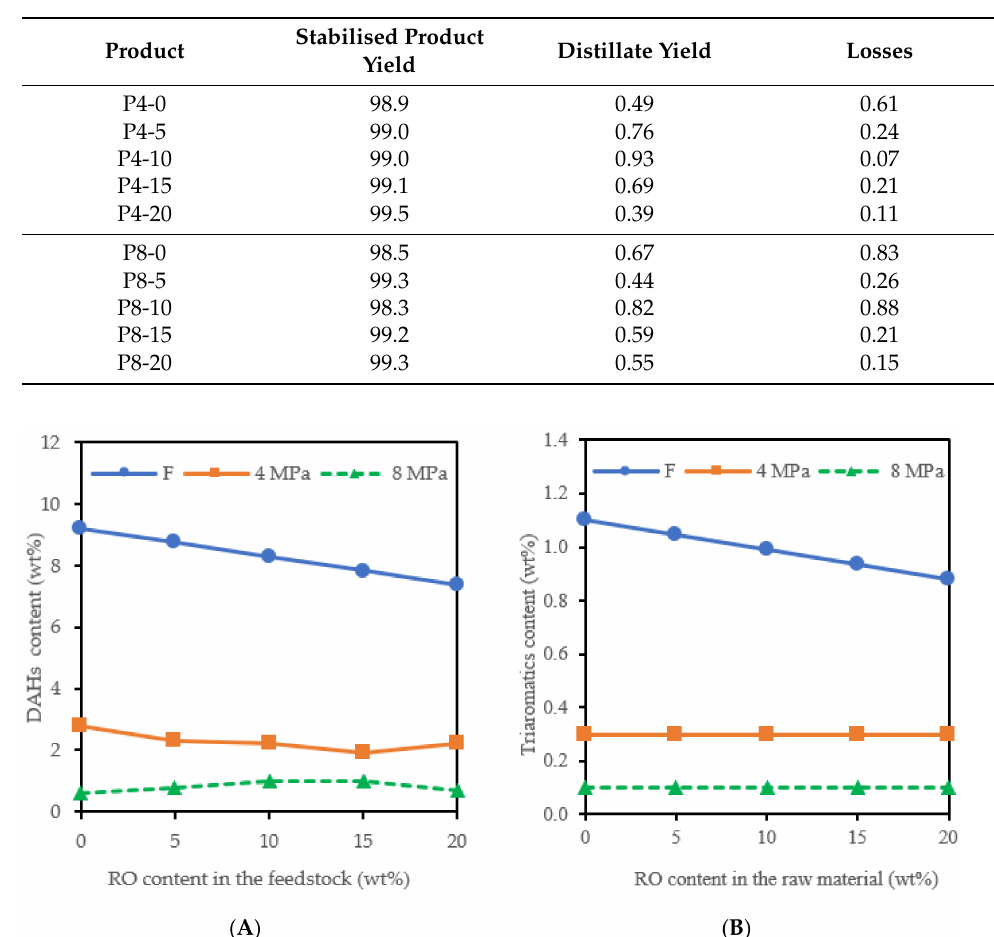
Figure 1. DAH ( A ) and TAH ( B ) content in the feedstocks (F) and the hydrotreated products (pressure of 4 and 8